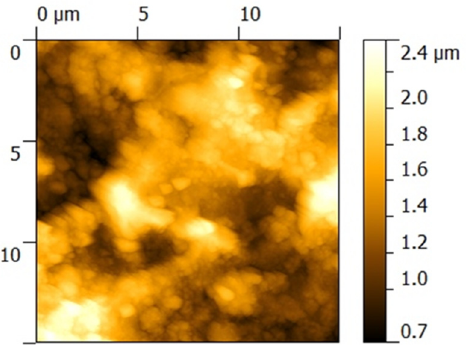
Figure 7. AFM image on 15 × 15 µm 2 surface areas of BG+CIPRO/PMMA thin films after 21 days of immersion in SBF. Table 2. Roughness values of thin films after 21 days of immersion in SBF.